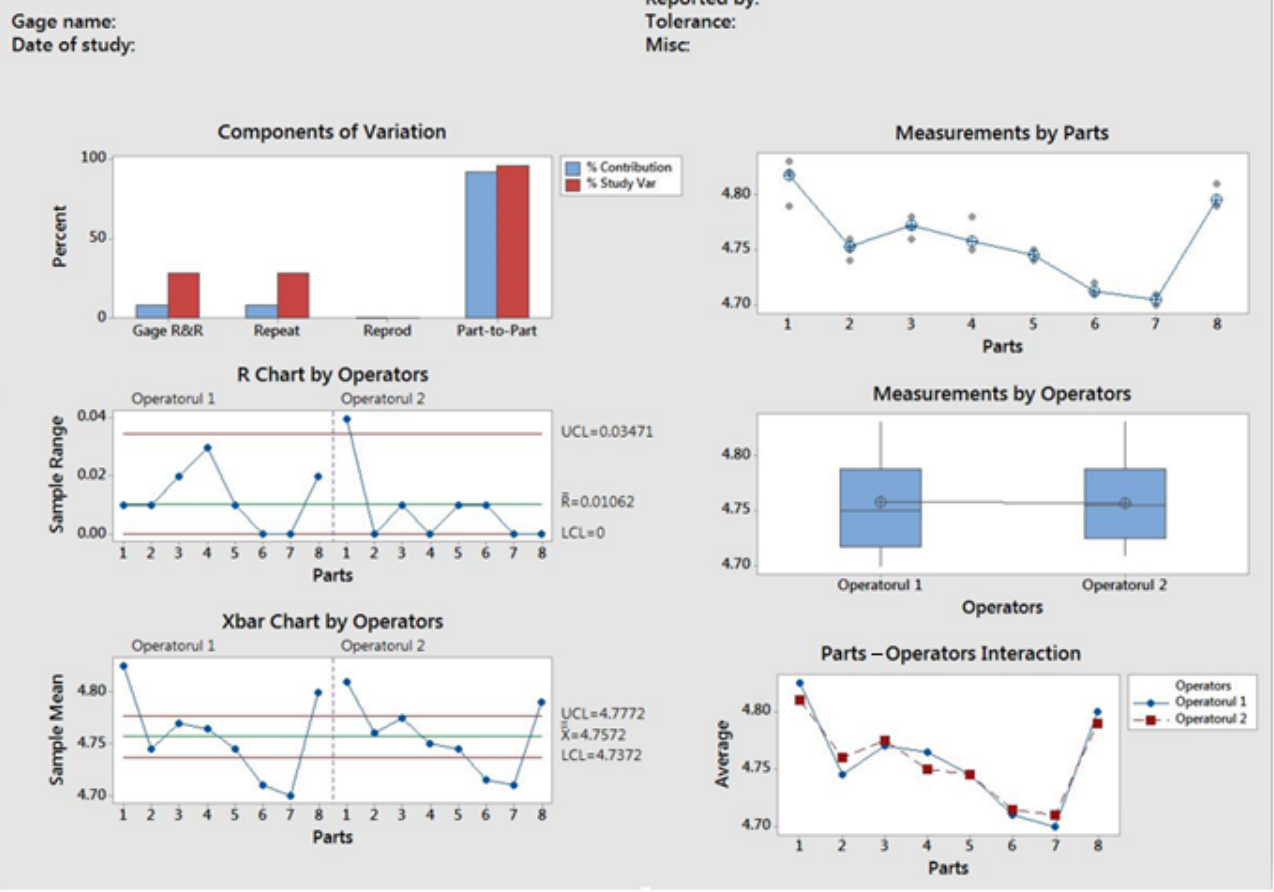
Figure 6. Graphical report of the measurements taken.